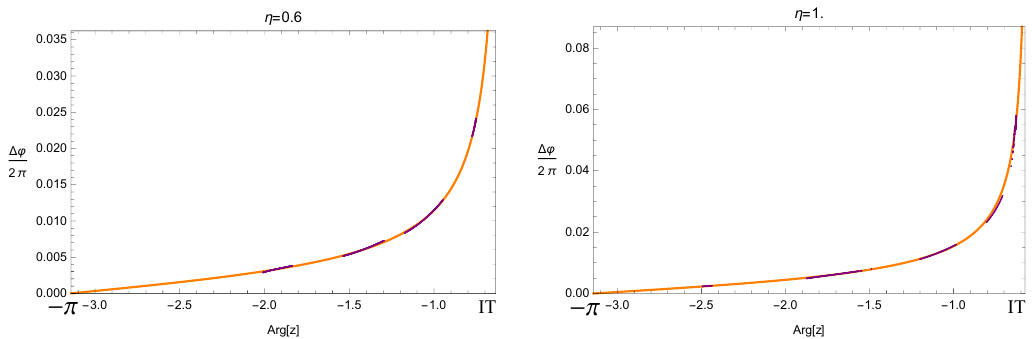
Figure 19. Upper bound on ∆ ϕ (4.8) as a function of φ ≡ arg( z ) , at smaller η values where more than one stable particle exists. The bound is obtained by fitting the non-CDD part of the elastic phase, similarly to that of figure 18, taking into account the known resonance zeros including z 0 (but without including z 0 x